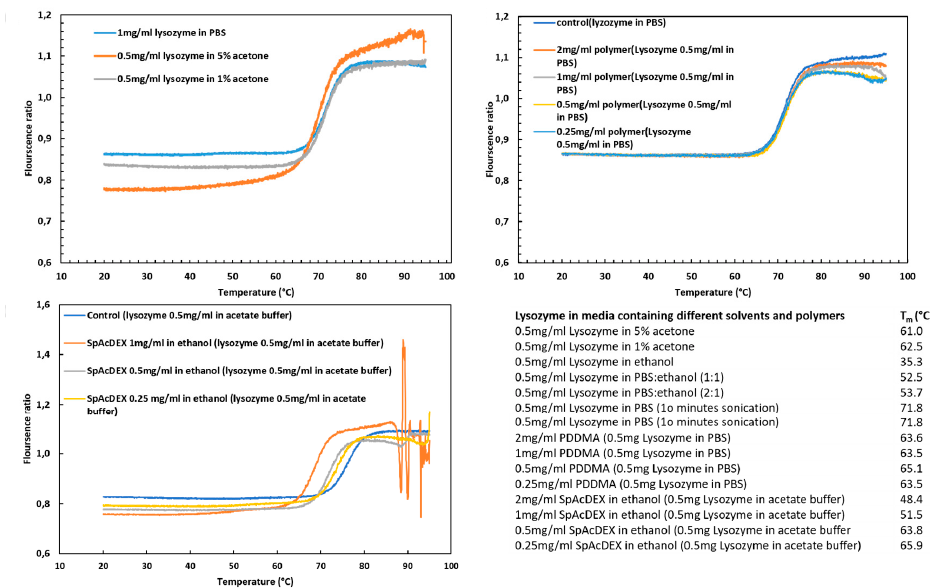
Figure 5. The effect of different solvent- and polymer-containing environments on lysozyme stability.